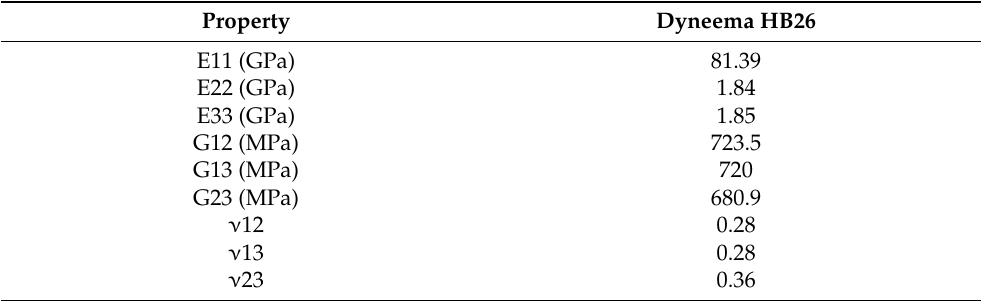
Table 1. Dyneema HB26 orthotropic layer properties, adapted from [25] E11, E22, E33 are the Young’s modulus in each of the three axes; G12, G13, G23 are the Shear modulus in each plane; and ν 12, ν 13, ν 23 are the Poisson ratio in each plane.